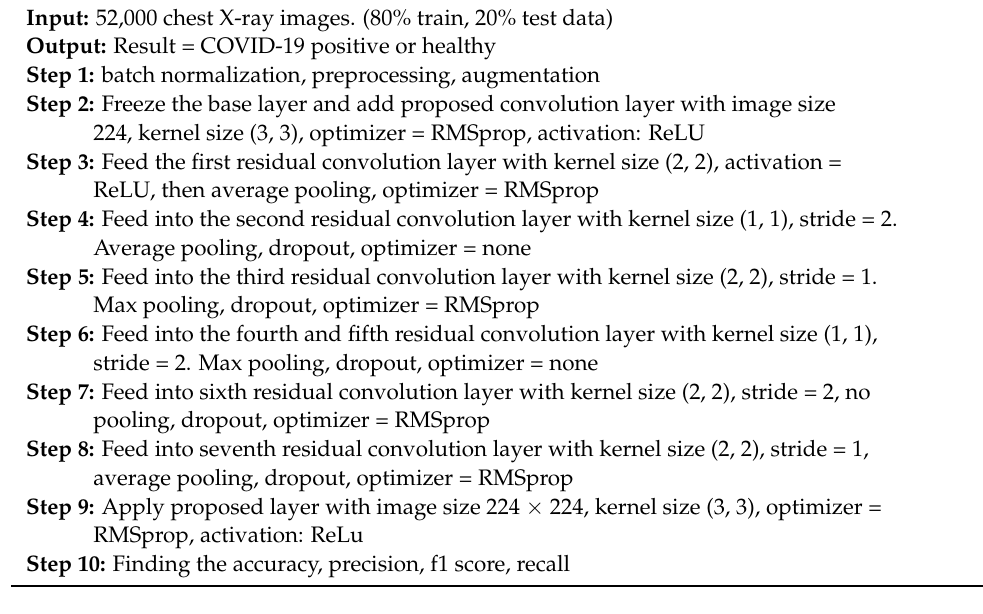
Algorithm 1: Proposed Modified MobileNetV2 Algorithm for COVID-19